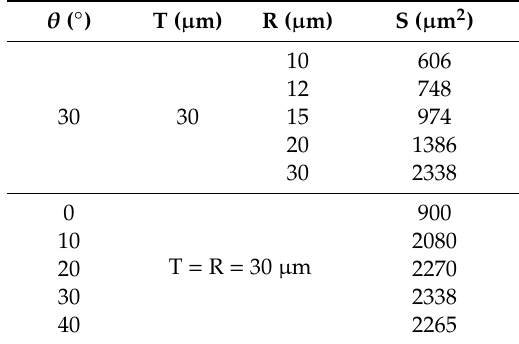
Table 2. Area of unit cells with di ff erent R, T, and θ values.